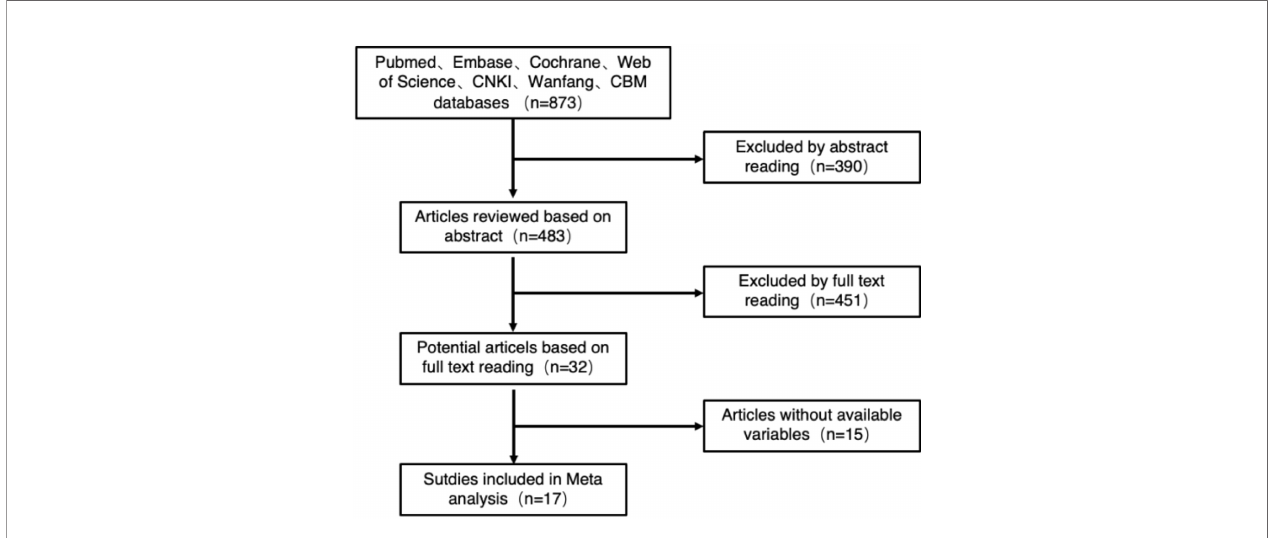
FIGURE 2 | Literature screening fl